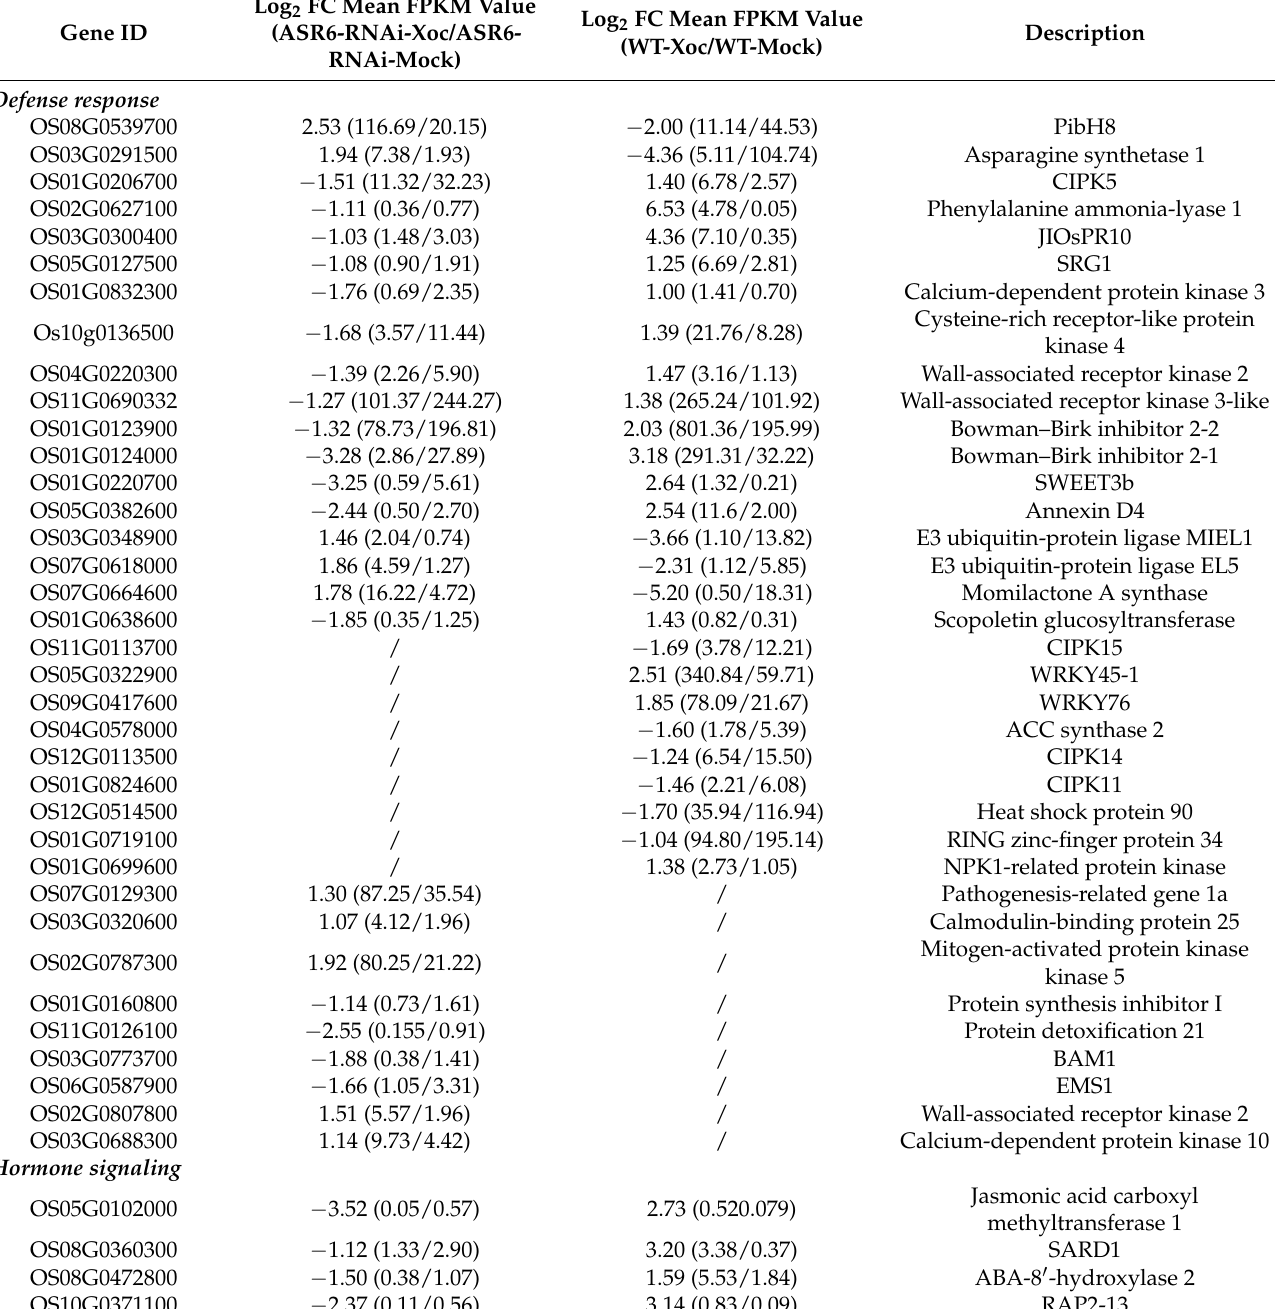
Table 1. Potential Xoc -responsive targets of OsASR6 function in suppressing rice